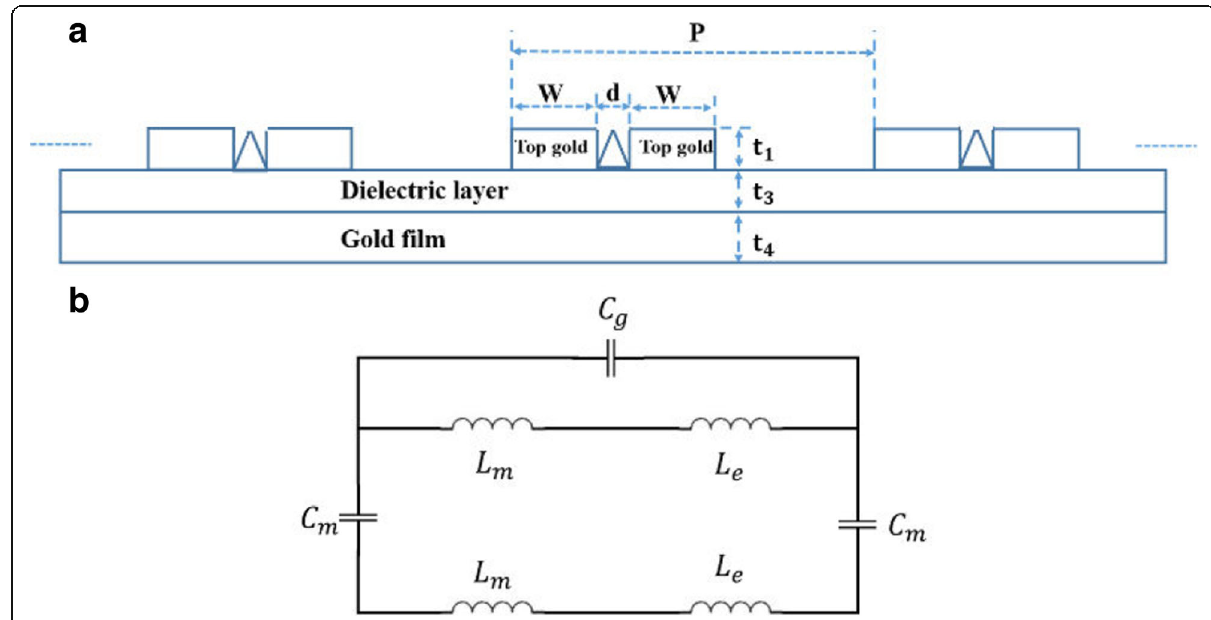
Fig. 2 a Schematic of the metamaterial absorber structure. b Schematic of the equivalent LC circuit model for the structure of Fig.